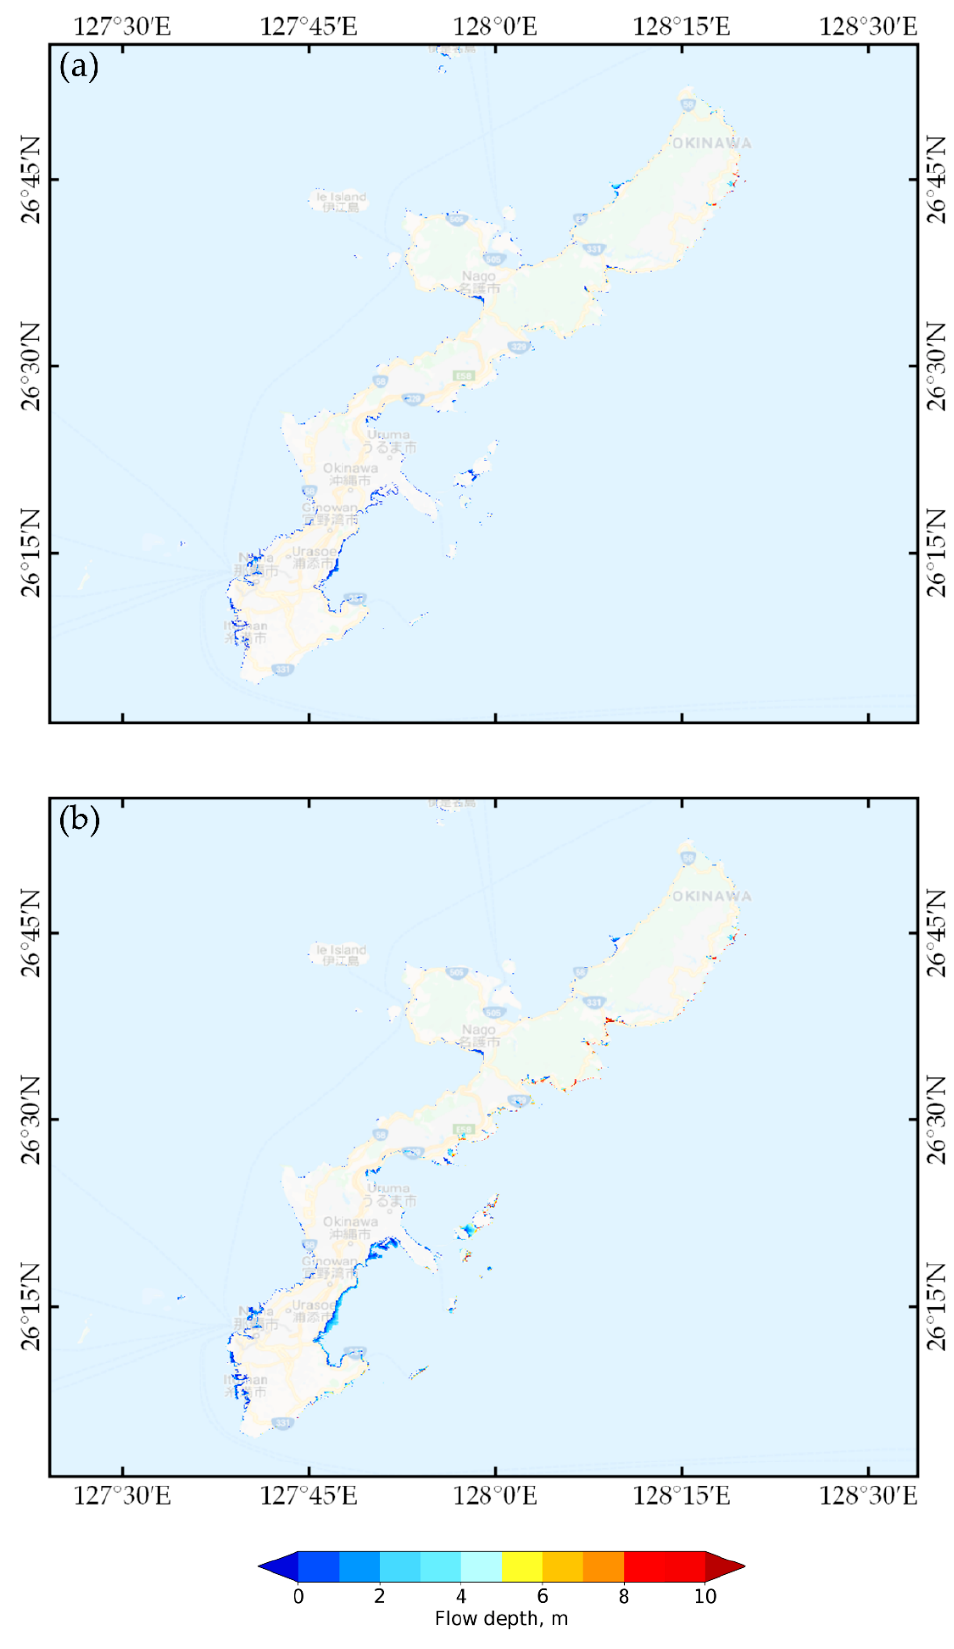
Figure 8. Maximum flow depth generated by the fault parameter of the earthquake scenario. ( a ) F1, Figure 8. Cont